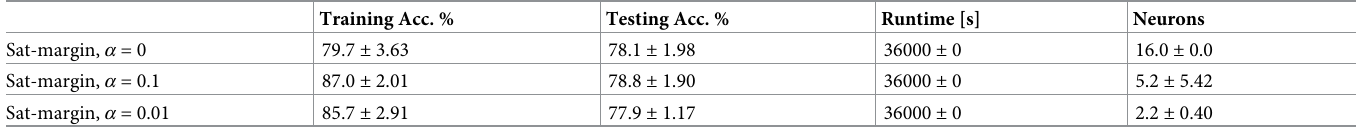
Table 2. Average results for Experiment 3 over five runs with standard deviation.